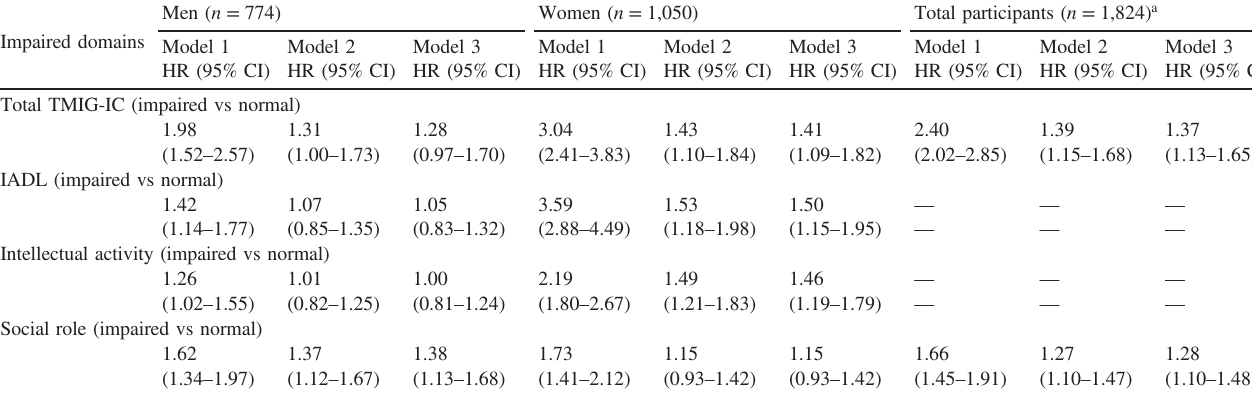
Table 2. Relationship of HLFC with all-cause mortality risk: 15-year follow-up of NIPPON DATA90, 1995 – 2010 Men ( n = Impaired domains